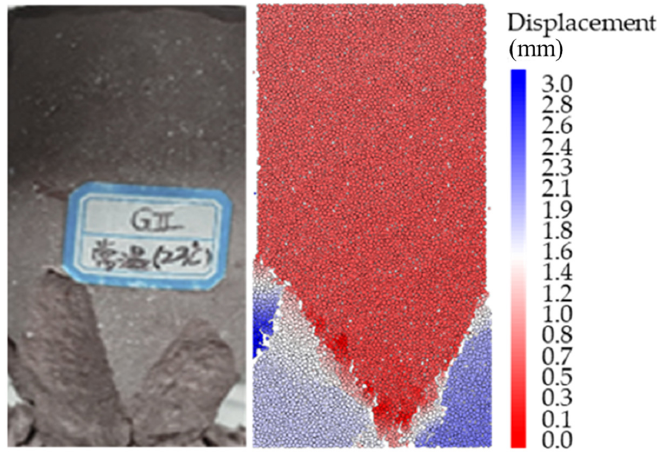
Figure 8. The creep-induced failure in experiment and numerical tests. (label: temperature 23 ◦